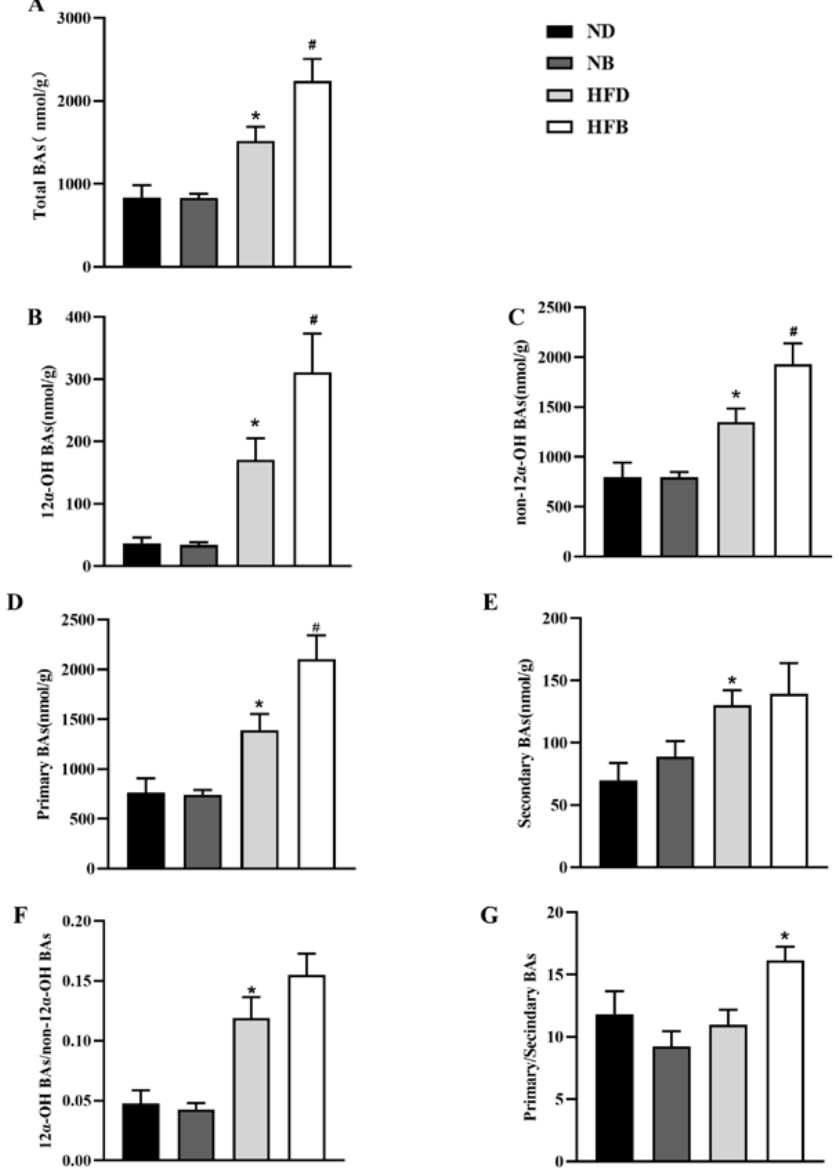
Figure 8. BCAA supplementation alters the bile acid composition in intestinal contents in ApoE − / − mice. Sixteen molecular species of BAs were determined in cecal and colonic contents by an LC − MS/MS method. ( A ) Total bile acid concentrations. ( B ) 12 α -OH BA concentrations. ( C ) Non-12 α -OH BA concentrations. ( D ) Primary bile acid concentrations. ( E ) Secondary bile acid concentrations. ( F , G ) The ratios of 12 α -OH BAs to non-12 α -OH BAs ( F ) and ratios of primary BAs to secondary BAs ( G ). The data are presented as the mean ± SEM ( n = 7–8 for each group). * p < 0.05 vs. ND group; # p < 0.05 vs. HFD